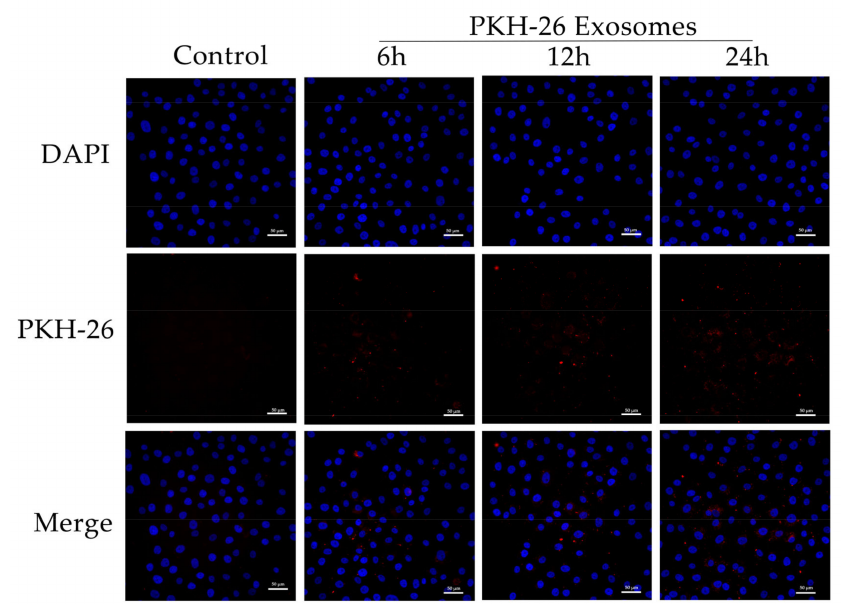
Figure 2. Uptake of yak follicular fluid exosomes by YCCs. Fluorescence microscopy confirmed the location of the yak follicular fluid exosomes that were tagged with PKH-26 (red fluorescence) in YCCs. Scale bar represents 50 µ m.